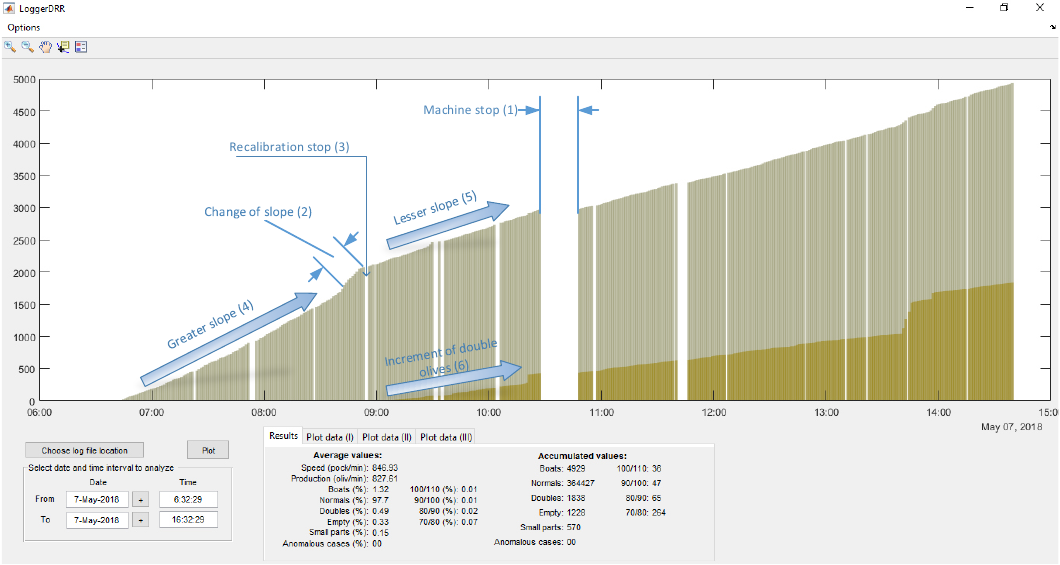
Figure 17. GUI of “boat” olives and doubles for the “DRR machine” diagnosis.